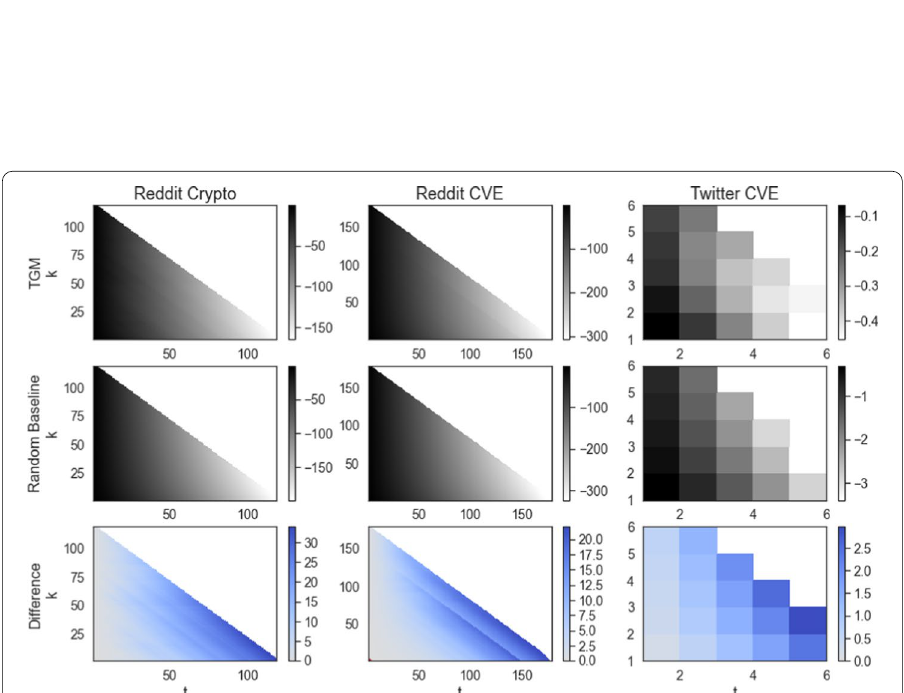
Fig. 10 Log‑probability of placing a consecutive sequence of t nodes correctly, starting from an initial partial tree with k nodes, for each model and dataset. We also plot the difference in log‑probabilities between TGM and the random baseline model, where blue regions show our model outperforming the baseline and red regions highlight the opposite case. Note that t + k is equal to the tree size, so that tree size is conserved on the diagonals of these